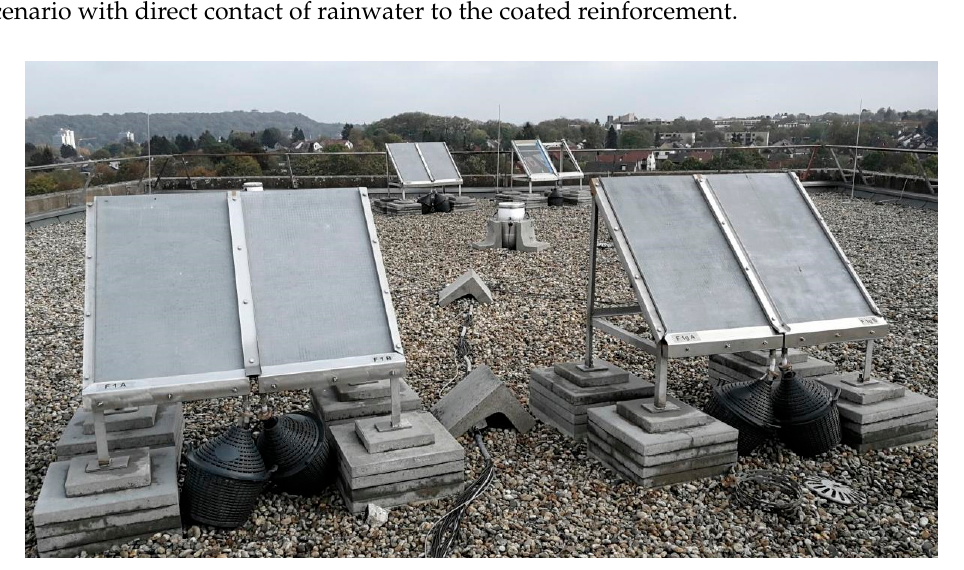
Figure 10. Outdoor testing stands on the roof of the RWTH Aachen University.